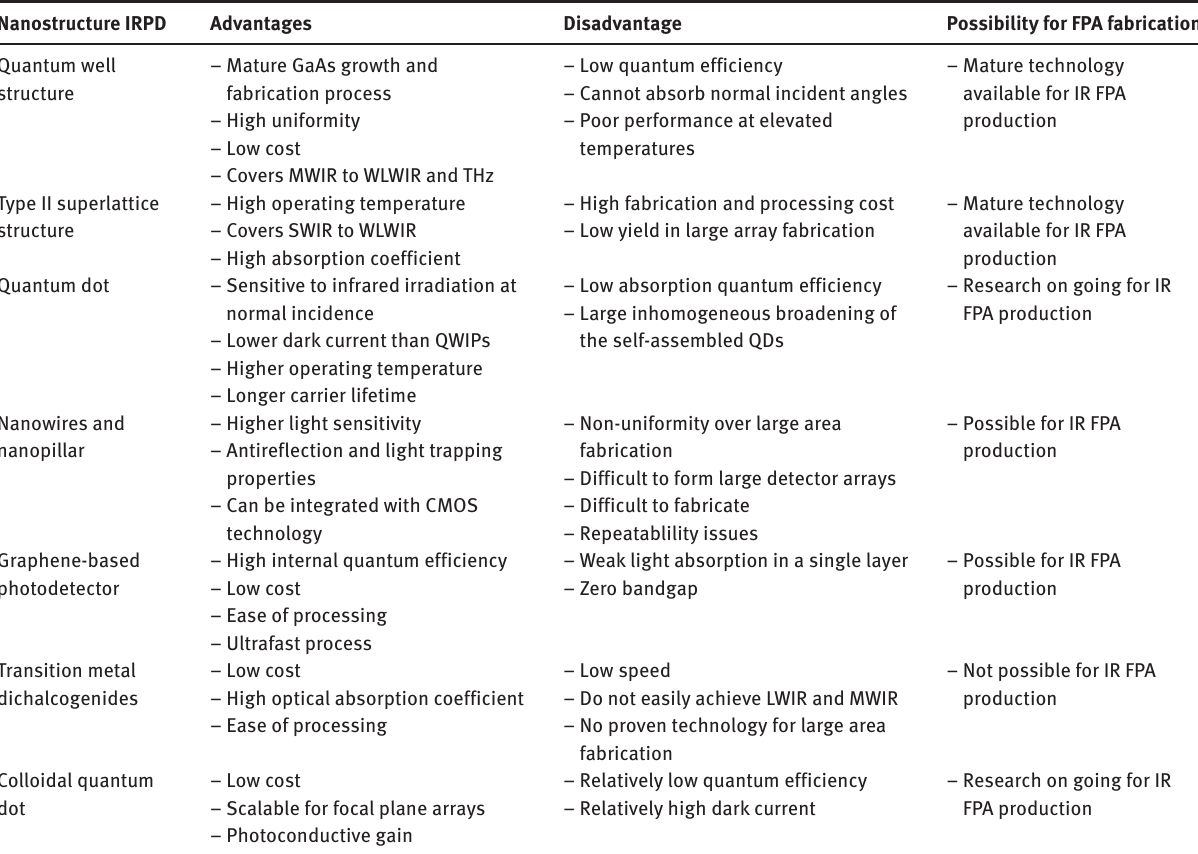
Table 2: Summary of the advantages and disadvantages of the current nanostructure-enhanced IR photodetector. Nanostructure